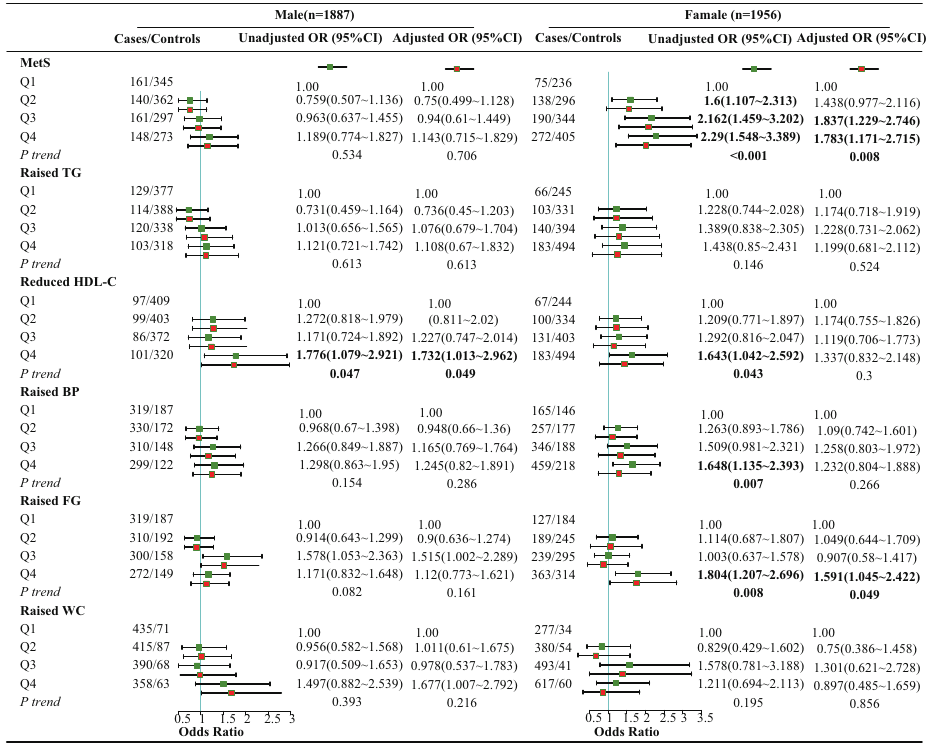
Figure 4. Subgroup analysis of association between DII and MetS as a whole and its components among different gender groups. Adjusted for confounding factors such as age, gender, race, education, poverty–income ratio, smoking, alcohol consumption, and sedentary behavior. Q1 [ − 5.21, − 1.33), Q2 [ − 1.33, 0.10), Q3 [0.10, 1.52), Q4 [1.52, 4.43) for male; Q1 [ − 4.71, − 0.54), Q2 [ − 0.54, 1.10), Q3 [1.10, 2.37), Q4 [2.37, 4.66) for female.